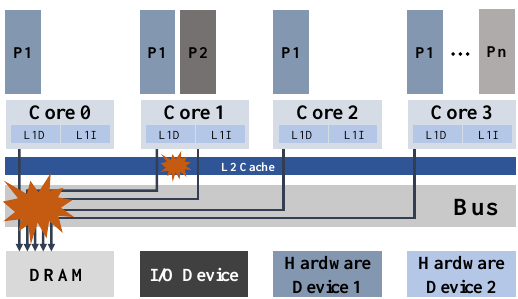
Figure 3. Memory sharing on multicore partitioning systems.